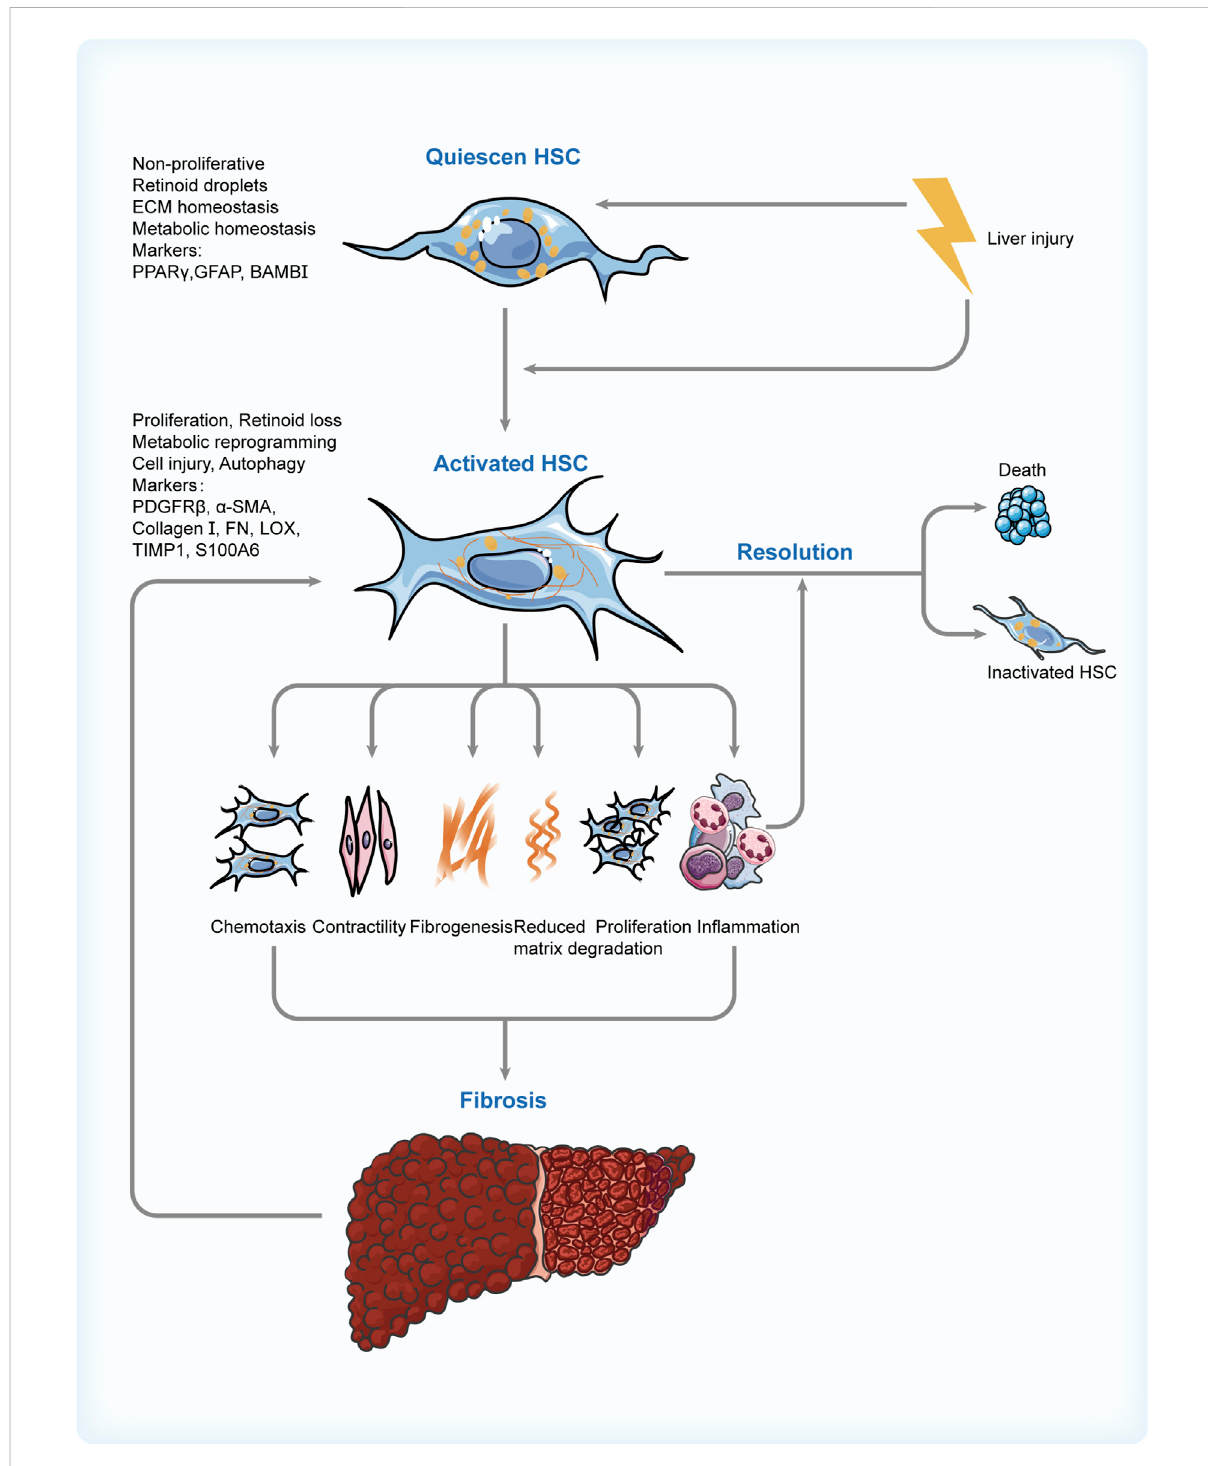
Switch of HSC phenotypes in NAFLD. Risk factors involved in the progression of NAFLD activate the HSCs and cause a sequence of changes in their features, phenotypes, and functions. These contribute to fi brogenesis and in fl ammation in the liver, which can promote the activation of HSCs inturnandcreateaviciouscycle.Thus,regulatingtheapoptosisofactivatedHSCanditsreversiontoinactivatedphenotypethroughvariousmeansis the critical resolution of NAFLD. HSC: hepatic stellate cell; NAFLD: non-alcoholic fatty liver disease; PPAR γ : peroxisome proliferator-activated receptor γ ; GFAP: glial fi brillary acidic protein; BAMBI: bone morphogenetic protein and activin membrane bound inhibitor; PDGFR β : platelet- derived growth factor receptor β ; α SMA: α -smooth muscle actin; FN: fi bronectin; LOX: lysyl oxidase; TIMP1: tissue inhibitor of metalloproteinase 1; S100A6: S100 calcium-binding protein